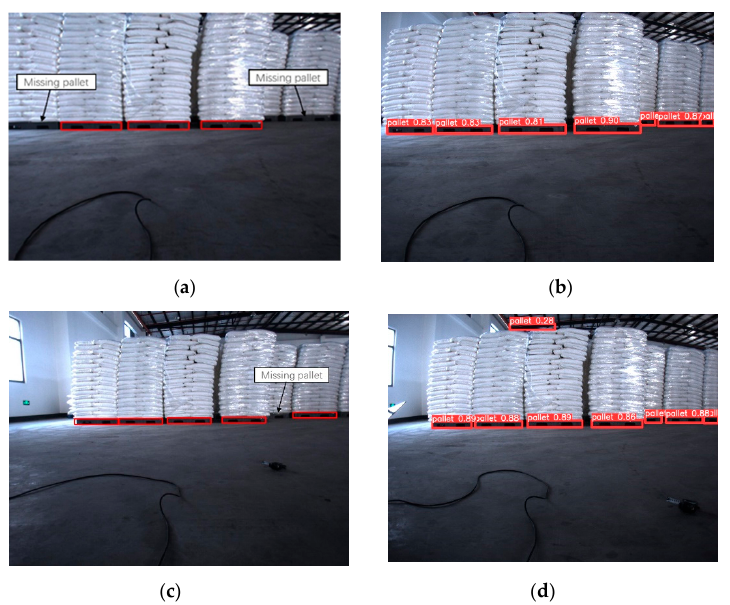
Figure 8. Multiple pallet recognition results contrast: The red box represents the results of the recognition algorithm. ( a , c ) is the recognition result of the proposed method, and ( b , d ) is the recognition result of yolov5.